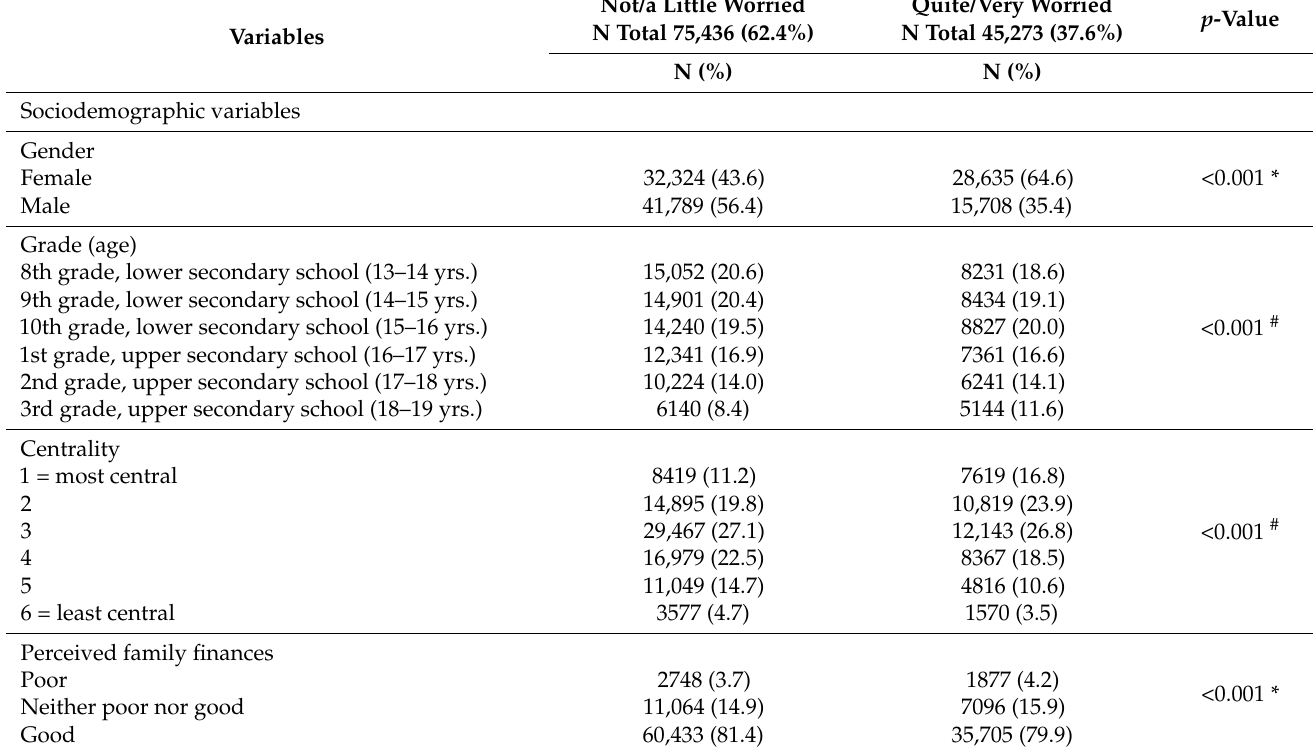
Table 1. Characteristics of the young people by presence and absence of worries about climate change.